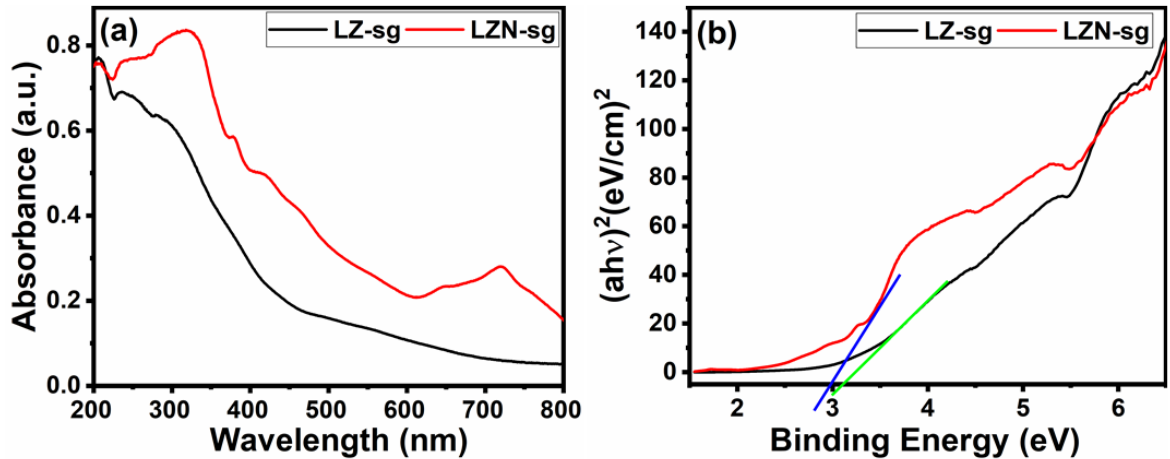
Figure 9. (a) UV – Vis spectra; and ( b ) band gap energy of LZ-sg (Green line) and LZN-sg (Blue line) pyrochlores.